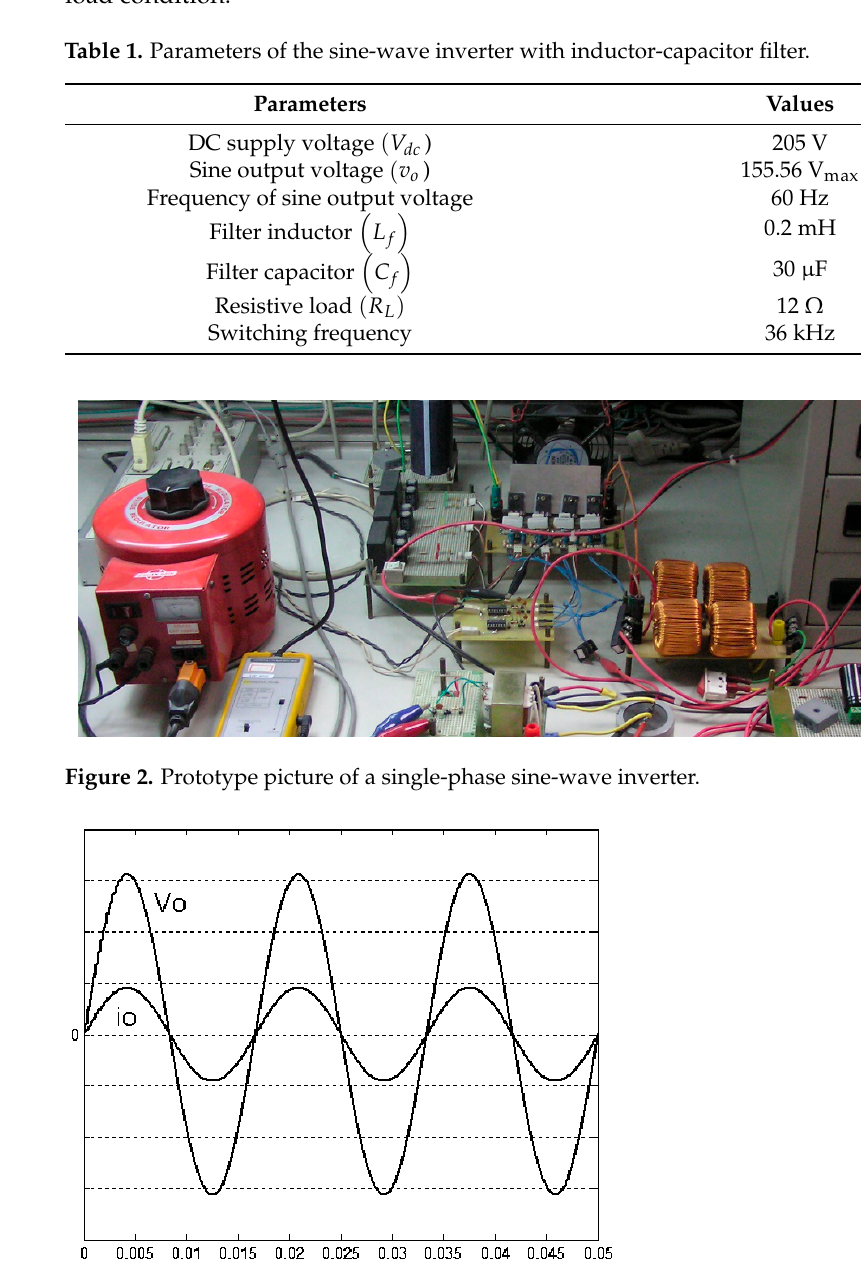
Figure 4. Output voltage and current for simulation of the proposed solution at full load (vertical: 50 V/div and 15 A/div). The simulated output waves of the sine ‐ wave inverter with conventional lim ‐ ited ‐ time convergent VSC operating under rectifier ‐ type load situation is graphically observed in Figure 5. Note that this is a distinguishable high %THD value of 18.29%. In Figure 6, a simulation of the output waves of the proposed sine ‐ wave inverter under rectifying load reveals the similar high sharp waves in the current, while the output voltage remains quite similar to the requisite sine wave (0.34% low THD value). It can be concluded that the proposed sine ‐ wave inverter delivers considerably improved stabili ‐ zation when compared to the conventional limited ‐ time convergent VSC sine ‐ wave in ‐ verter for a rectifier ‐ type load condition.